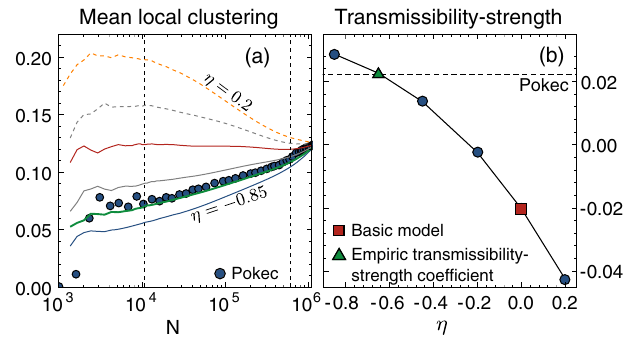
FIG. 7. (a) Evolution of the mean local clustering coefficient for different values of η from − 0 . 85 to 0.2. The lines correspond to model results for different η and the symbols represent the evolution from the empiric network. We set λ ¼ 0 . 03 and μ ¼ 0 . 006 . (b) Slopes of the evolution of the mean local clustering coefficient for different values of the transmissibil- ity-strength coefficient. The dashed line represents the slope of the clustering evolution of the Pokec network. The empirical transmissibility-strength coefficient η ¼ − 0 . 65 is given by the intersection of this line with the curve representing the model